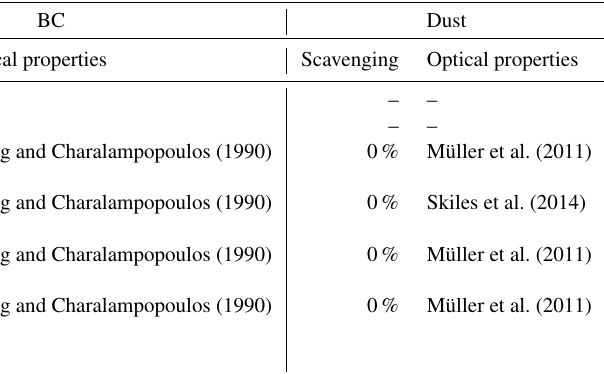
Table 1. Crocus configurations